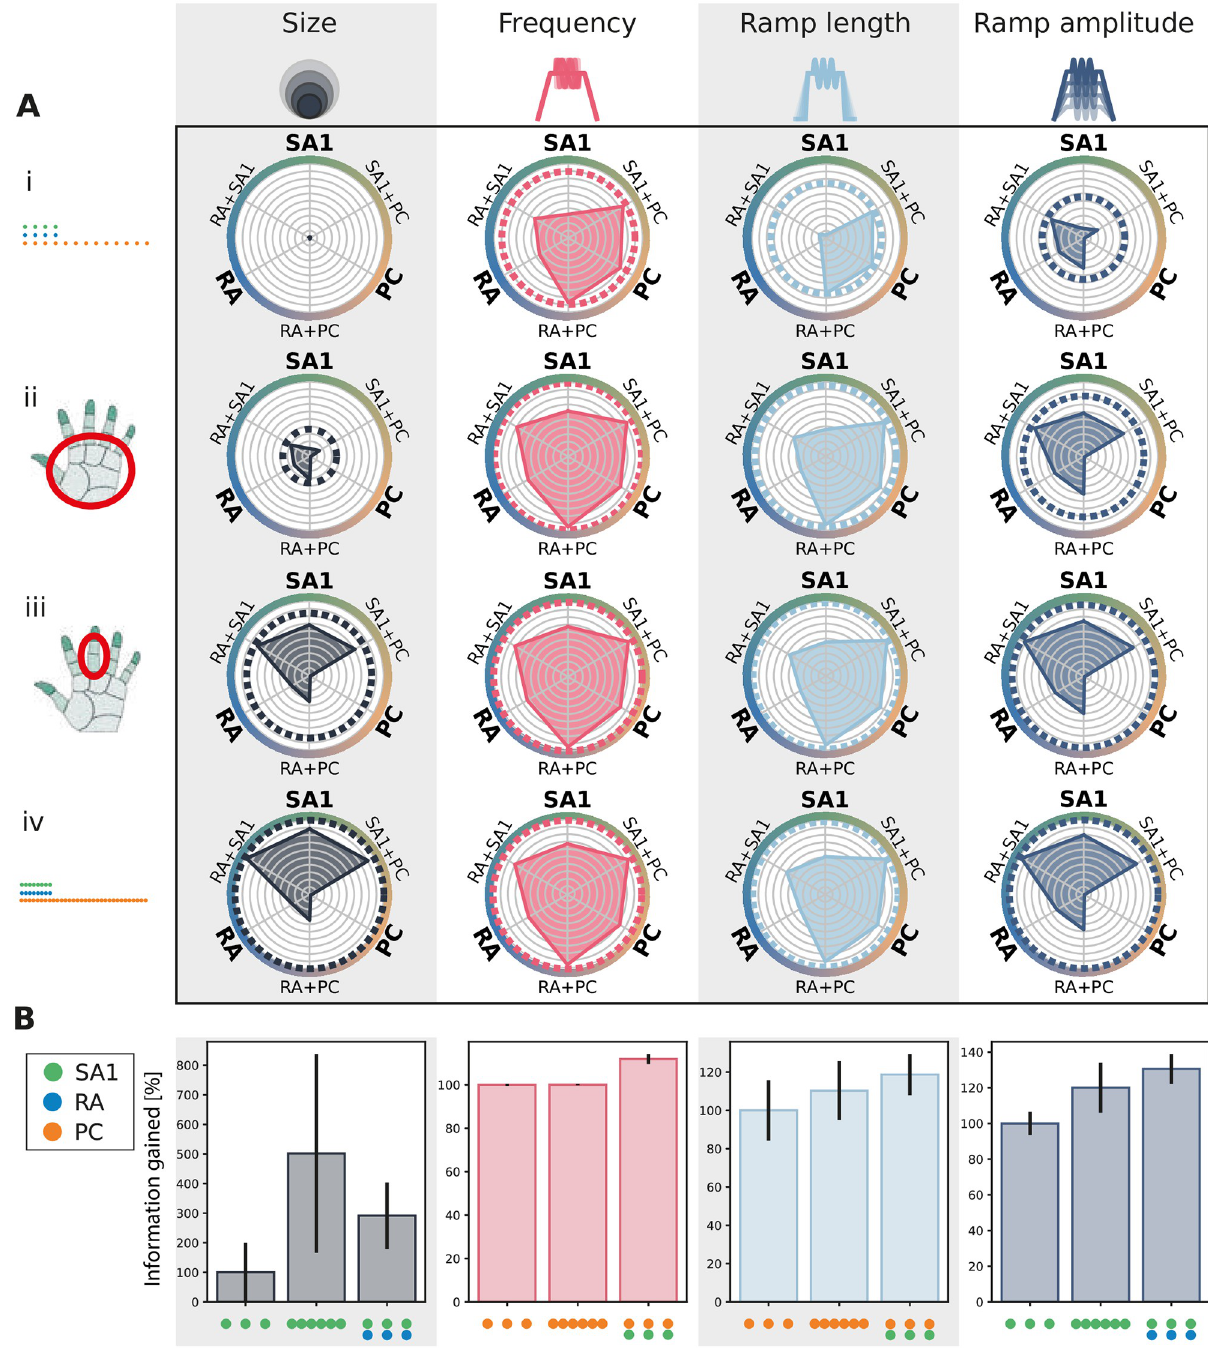
Fig 5. Information gain at different afferent densities. (A) Radar plot of the information content provided by single and combined classes at different densities for individual tactile features. Each radial axis represents the information content of a single afferent class or combination of two classes. Dotted circular lines correspond to the information given by the three afferent classes together. Information is normalized for each stimulus feature with respect to the information provided by the three classes altogether at the upper-limit density (i). Four different density sets were considered: (i) lower limit, (ii) human palm, (iii) human finger, and (iv) upper limit as reported in the Methods. (B) Comparison of the information gained when doubling the density of the most informative class (central bar) or when combining with a different population (right bar). The baseline density (left bar) was set at 10 afferents/cm 2 . Error bars represent standard deviation across different NMF